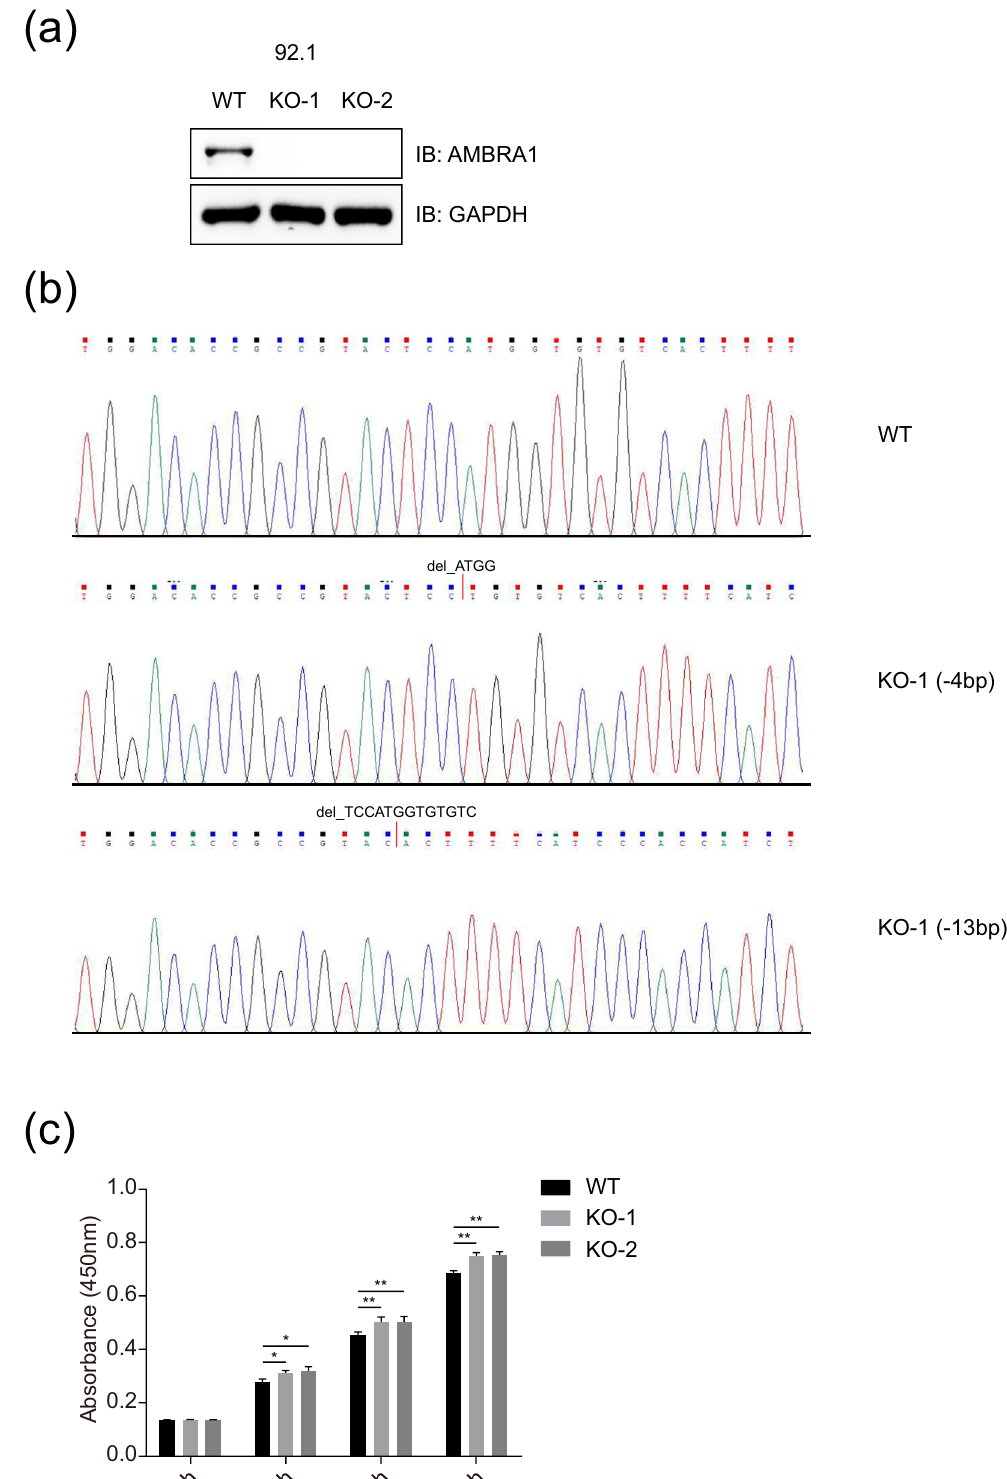
Figure A2: The knockout of AMBRA1 promotes the proliferation of 92.1 cells. ( a and b ) Two AMBRA1 knockout ( KO ) cell lines were generated using the CRISPR - CAS9 technique. 92.1 cells were transfected with CRISPR - CAS9 - based sgRNA, monoclonal were picked and detected by immunoblotting analysis ( a ) , and then the genetic ablation of AMBRA1 with a 4 - bp and a 13 - bp deletion were con fi rmed by Sanger sequencing ( b ) . ( c ) AMBRA1 knockout promoted the proliferation of 92.1 cells. Wild type ( WT ) and AMBRA1 knockout 92.1 cells were seeded into 96 - well plates, and the cell viability was detected using the CCK - 8 assay at the indicated time points. The data were expressed as mean ± SD and analyzed using one - way ANOVA with Tukey ’ s post - hoc test. NS, no signi fi cantly di ff erent; **P < 0.01, very signi fi cantly di ff erent, the experiment was repeated three